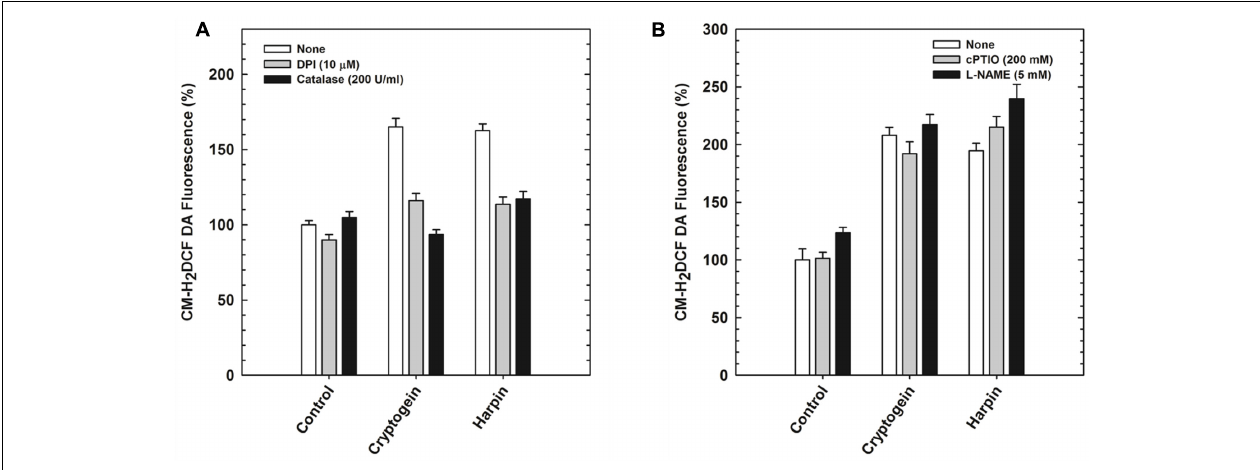
FIGURE 5 | The elevation of ROS levels, (indicated by CM-H 2 DCFDA) by cryptogein or harpin, in the absence or presence of ROS/NO modulators. The levels of ROS in guard cells were more, when treated with cryptogein and harpin, than their respective controls. The extent of increase in ROS by cryptogein or harpin was reduced by ROS modulators (catalase, ROS scavenger and DPI, NADPH oxidase inhibitor) (A) . In contrast, elicitor-induced increase was unaffected by NO modulators (cPTIO, NO scavenger and L -NAME, NOS inhibitor) (B) . Further details are as in Figure 3 and “Materials and Methods.”